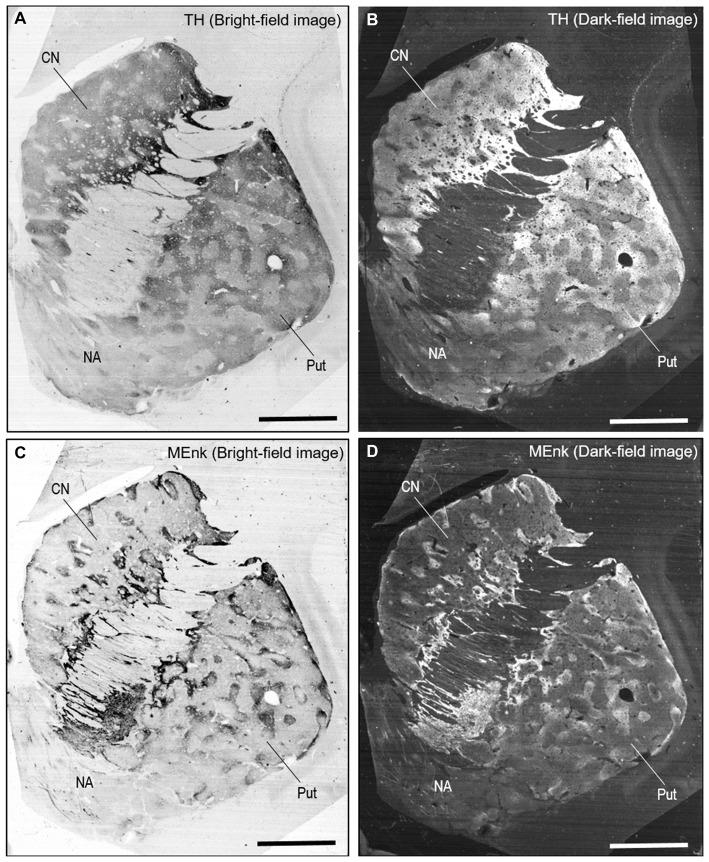
Non-homogeneous distribution of TH in the human neostriatum. (A,B) Bright-field (A) and dark-field (B) images taken from a frontal section of the striatum stained with diaminobenzidine (DAB) for TH. (C,D) Bright-field (C) and dark-field (D) images taken from a frontal section of the striatum stained with DAB for [Met]-enkephalin (MEnk), a marker for striosomes (patches). Note that they are contiguous to those shown in (A,B). Abbreviations: CN, caudate nucleus; Put, putamen; NA, nucleus accumbens. Scale bars: 5 mm.